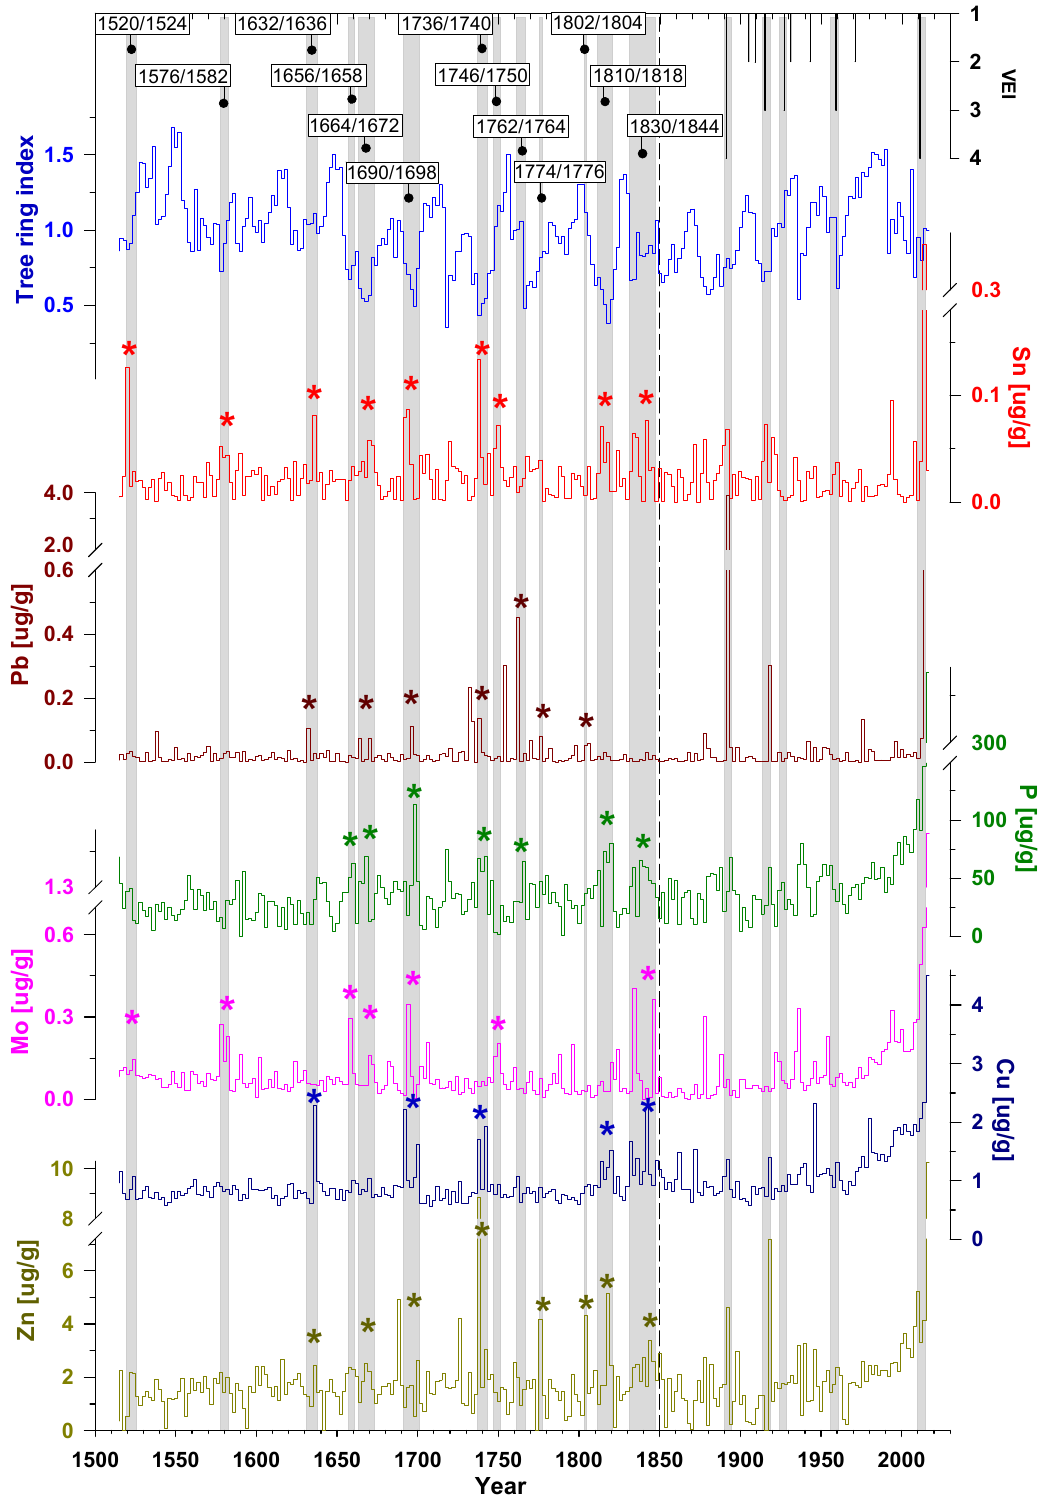
Figure 7. The Cayutué F. cupressoides dendrochemical (Sn, Pb, P, Mo, Cu, Zn) and ring-width chronologies. All registries have a biennium resolution. Vertical gray lines indicate the eruption dates of the Calbuco volcano during the historical period after 1850 (VEI ≥ 3 according to Petit-Breuilh [51], Sellés and Moreno [50], Global Volcanism Program [52]), and the possible dates of past eruptions during the 1514–1848 period inferred from the co-occurrence of concentration values of chemical TPEs above the 90th percentile of each chemical series for at least ≥ 2 chemical tracers, indicated by asterisks.